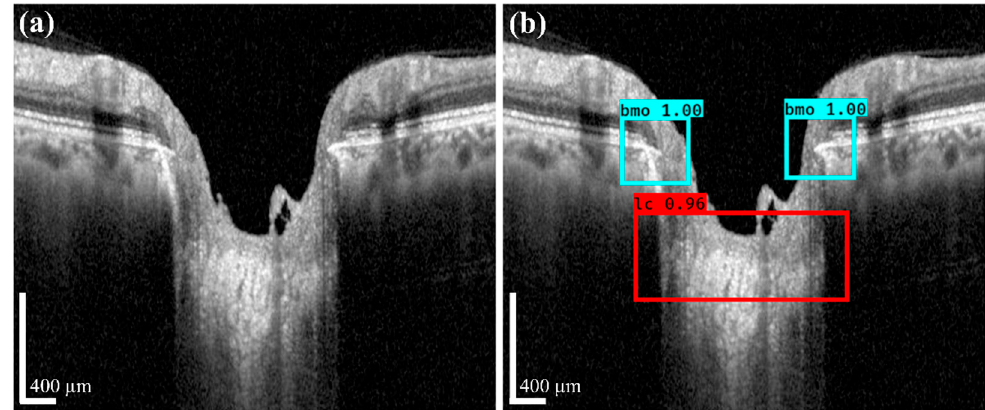
Figure 8. ( a ) An image used for learning the coarse detector performance; ( b ) the prediction results for the corresponding image (the cyan boxes represent the BMO detection area, and the red box represents the LC detection area). Scale bar: 400 µm.